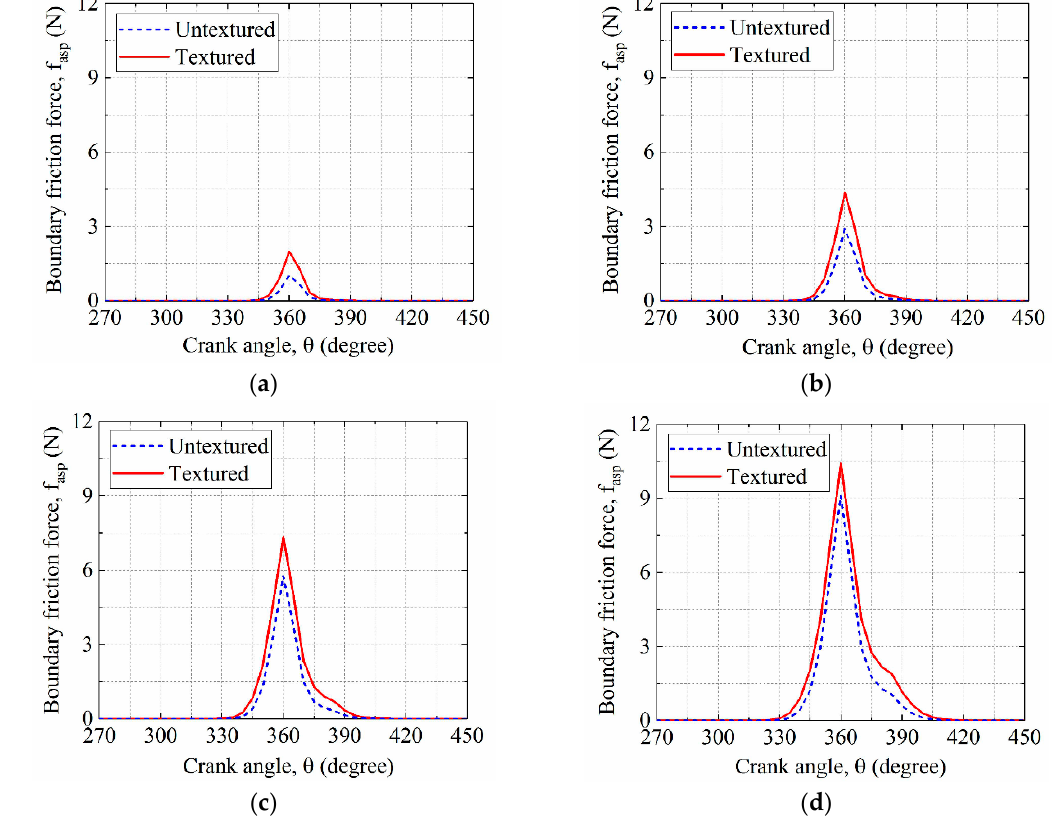
Figure 16. Boundary friction forces of the textured RLC and untextured RLC: ( a ) T liner is 60 °C; ( b ) T liner is 80 °C; ( c ) T liner is 100 °C; ( d ) T liner is 120 °C.